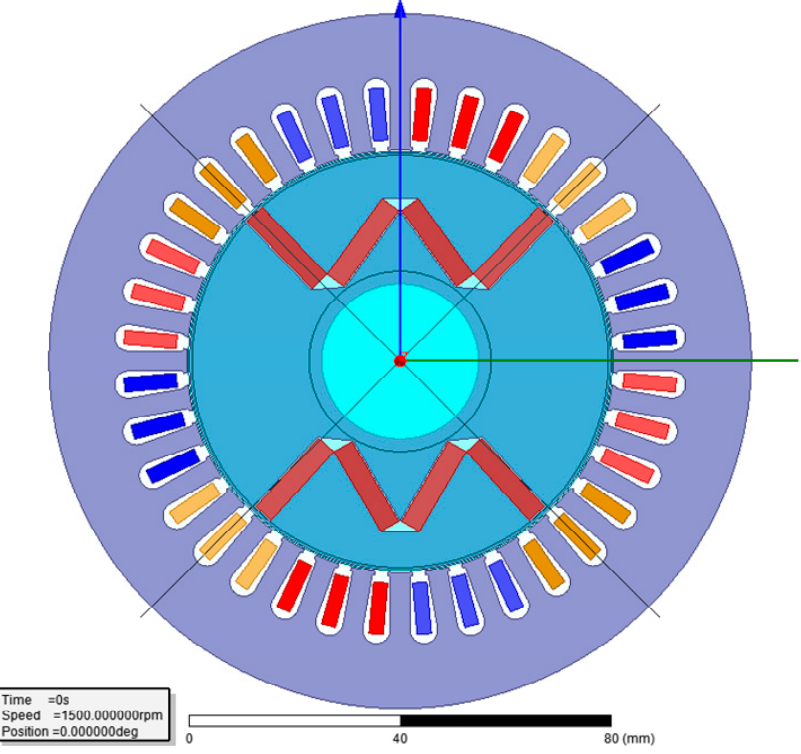
Figure 3. Transverse view of the PMSG geometry.